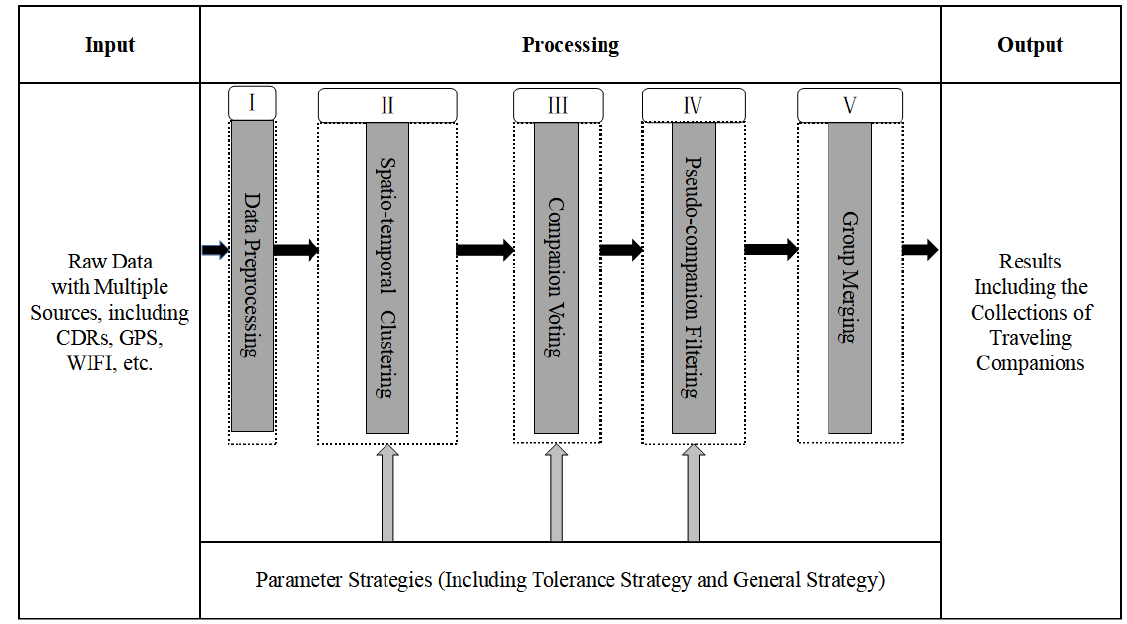
Figure 2. The framework of the entire